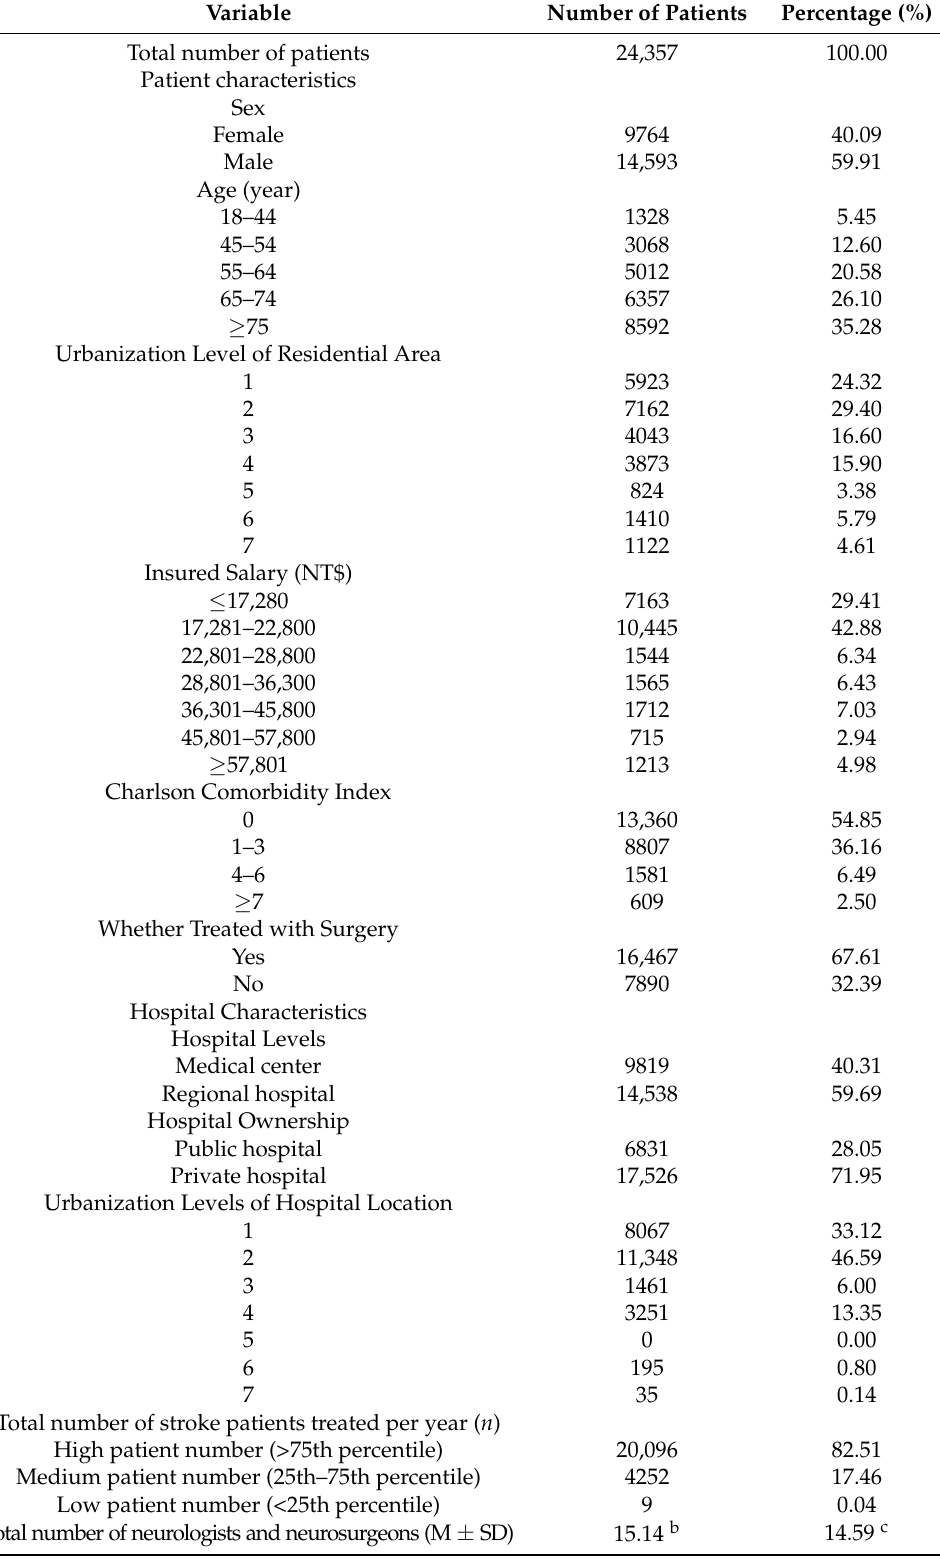
Table 1. Basic characteristics of patients with